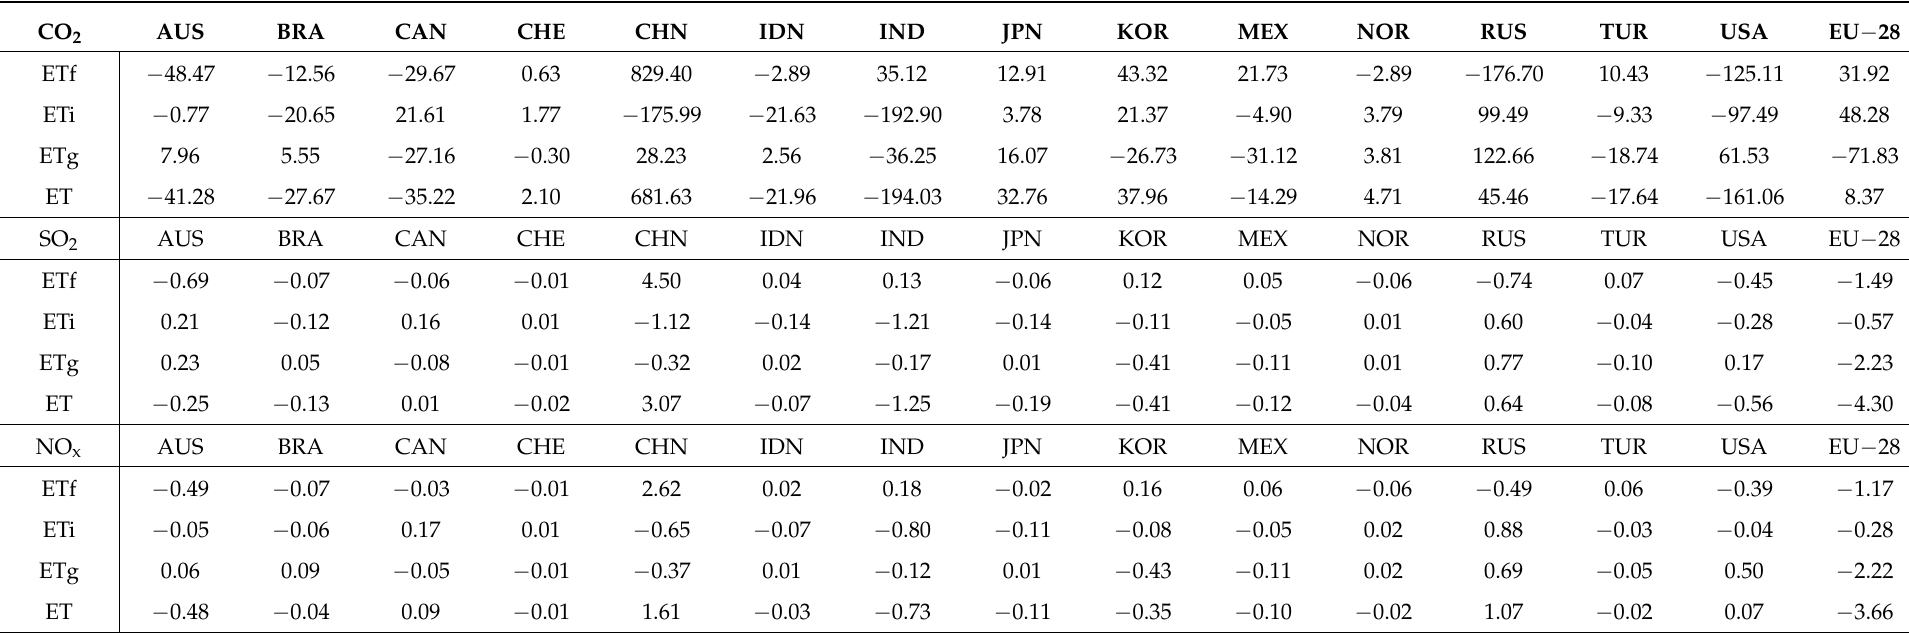
Table A6. Assess major countries in different patterns of pollution